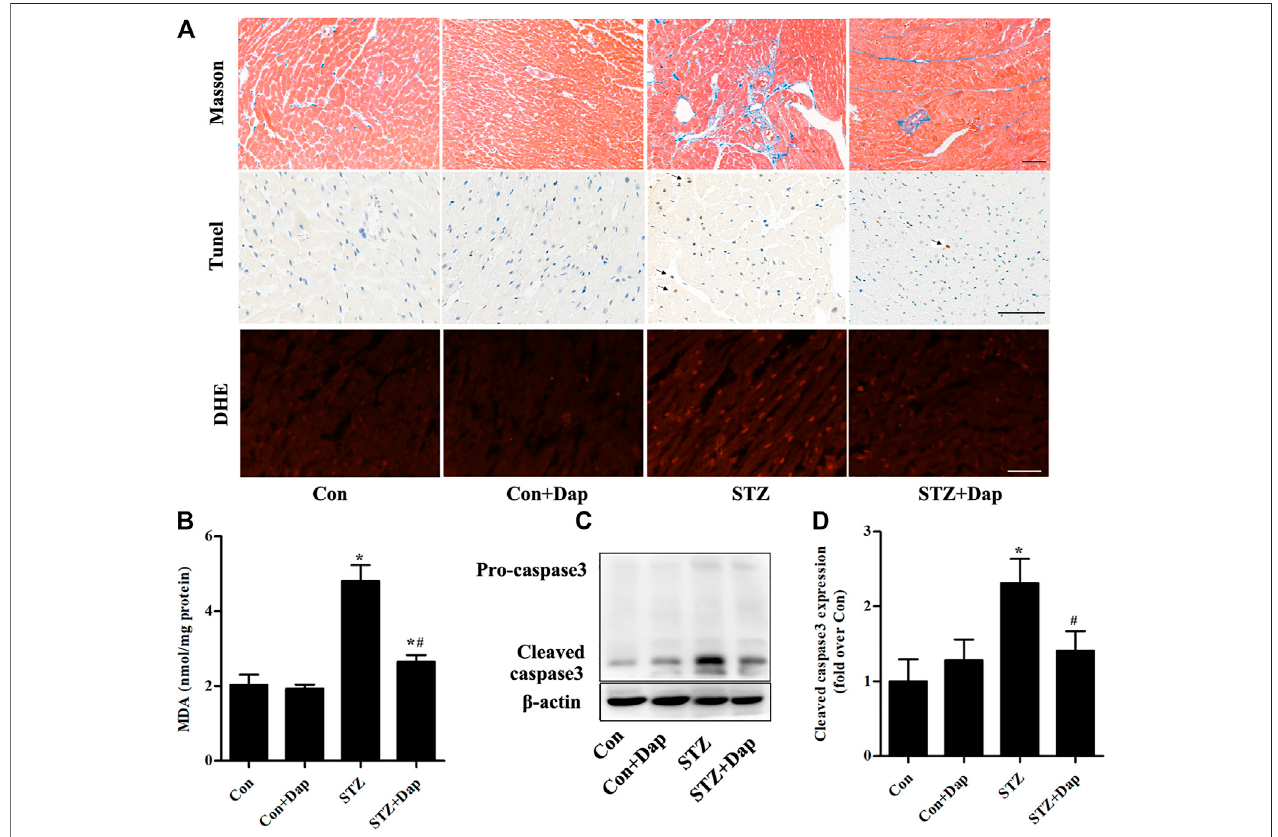
FIGURE 2 | Effects of DAP on myocardial fi brosis, apoptosis and oxidative stress in diabetic rats (A) Upper panel, Masson ’ s trichrome staining of myocardium sections. Middle panel, TUNEL detection of apoptotic cells in the myocardium. Arrows point to TUNEL positive cells. Lower panel, heart sections were incubated with dihydroethidium (DHE) to evaluate superoxide anion. Scale bar (cid:1) 100 µm (B) Myocardial malondialdehyde (MDA) concentration was assessed. n (cid:1) 7 (C,D) Panel and histogram represent the expression of cleaved caspase 3 in myocardial tissues of rats. n (cid:1) 3 – 4. Data are expressed as the mean ± SD. * p < 0.05 vs. Con; # p < 0.05 vs.